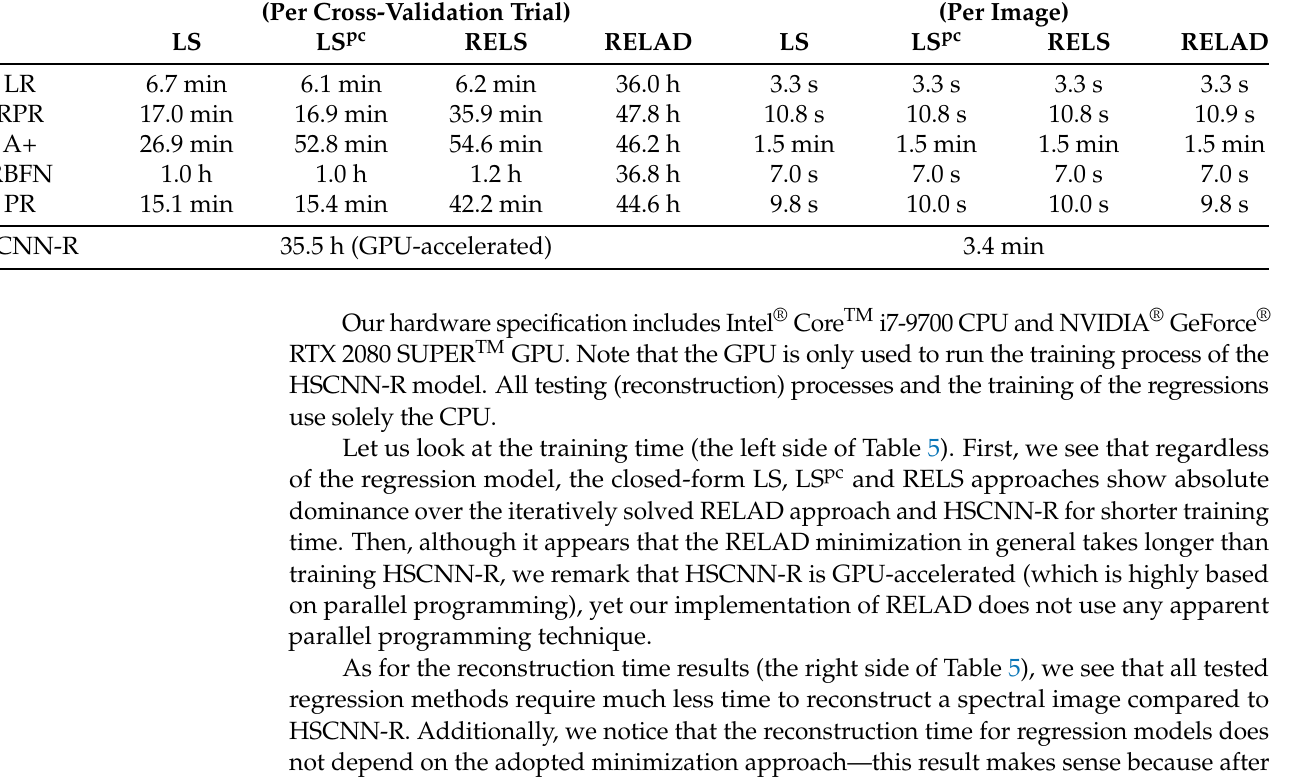
Table 5. The training and reconstruction time measurements. The size of the reconstructed images (from the ICVL database) is 1392 × 1300 with 31 spectral channels, and the training set (for each cross-validation trial) is composed of 100 images. Training Time Reconstruction Time (Per Cross-Validation Trial) (Per Image) LS LS